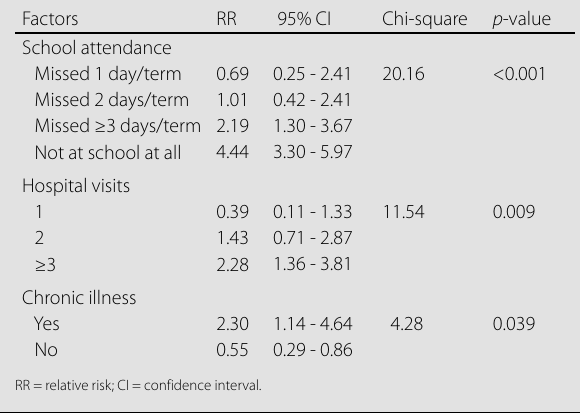
Table IV. Relative risk analysis of associated factors identified with presence of a psychiatric